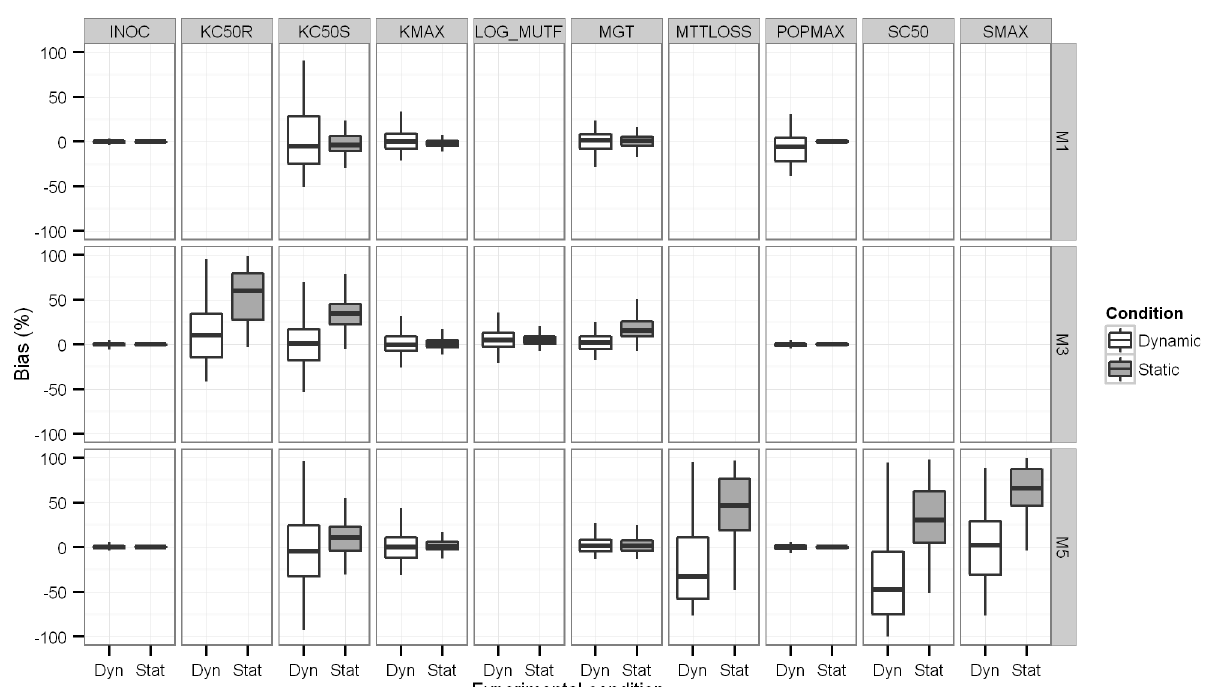
Fig 4. Boxplots of the bias between true and estimated parameter values under static and dynamic